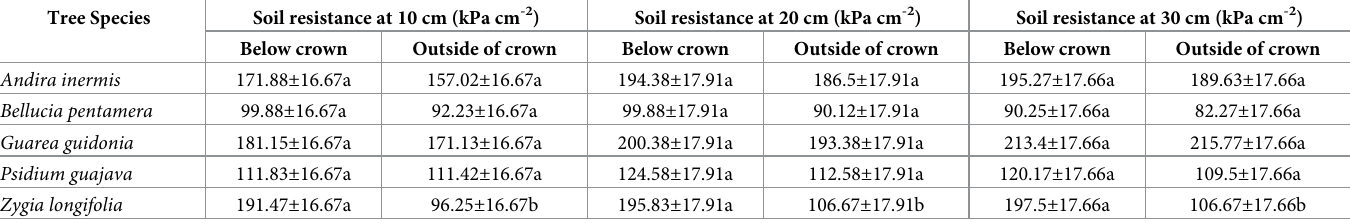
Equal letters between species indicate equal means (P >